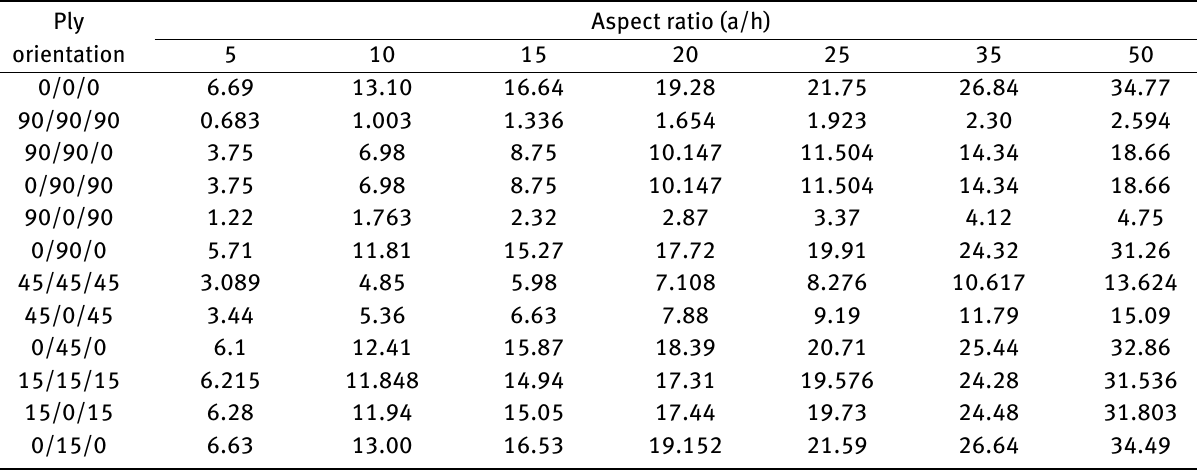
Table 3: Effect of orientation on critical buckling load under distributed compressive load Ply Aspect ratio (a/h) orientation 5 10